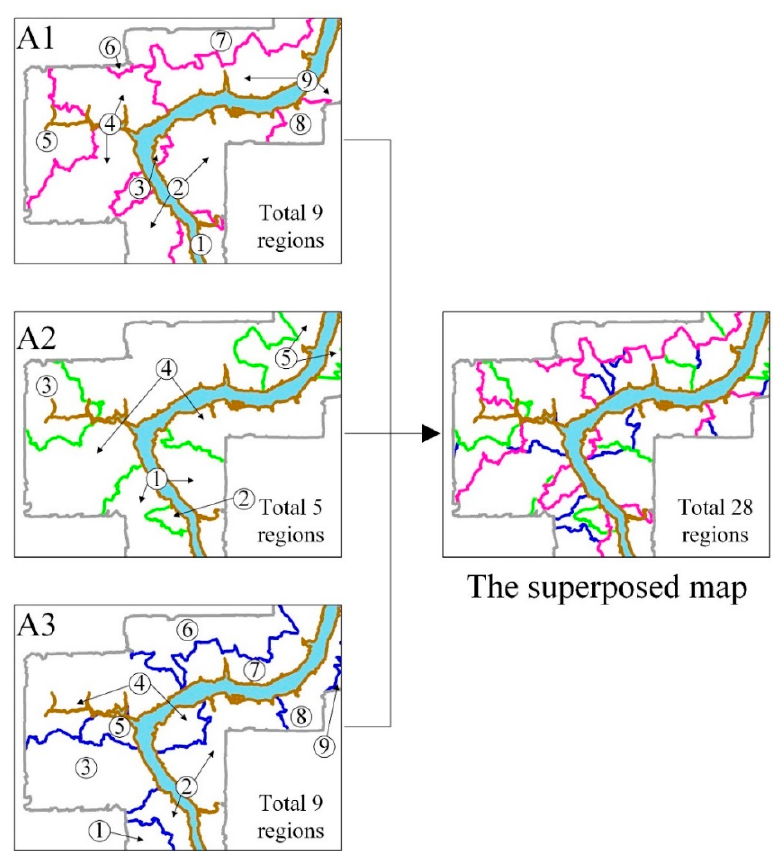
Figure 5. The superposition of classification maps of three environmental factors A1, A2 and A3.